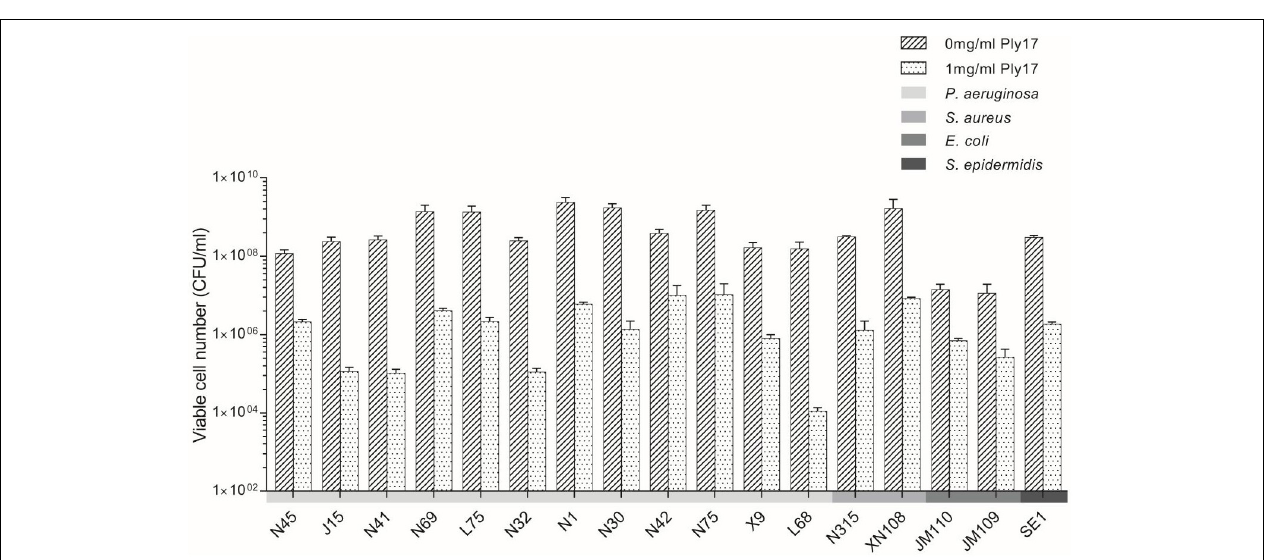
FIGURE 4 | The bactericidal activity of Ply17 versus Gram-negative and Gram-positive bacteria. Ply17 has a broad antimicrobial spectrum, which is active against P. aeruginosa , E. coli , S. aureus , and S. epidermidis .